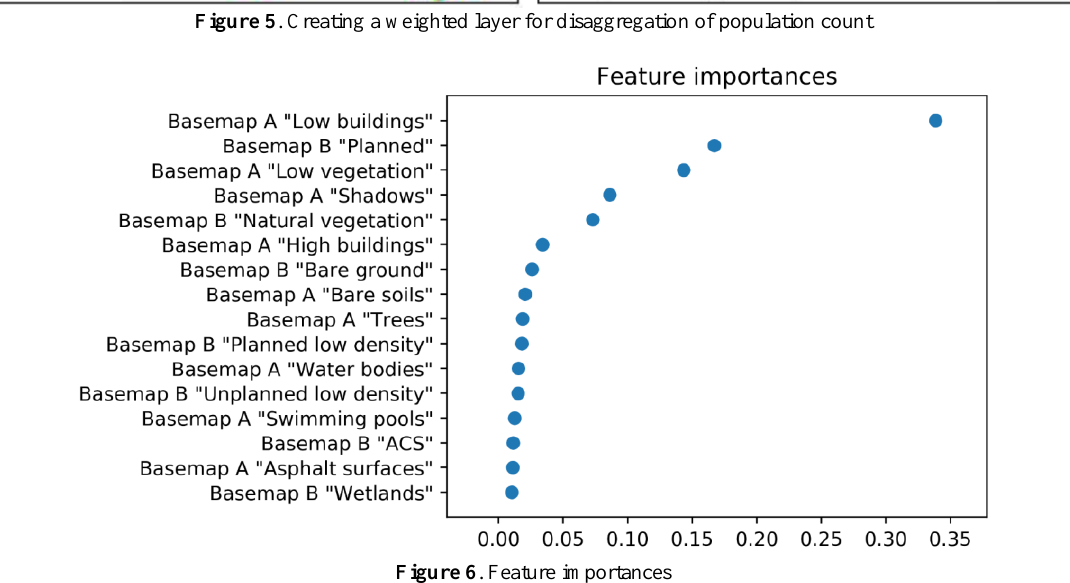
Figure 6 . Feature